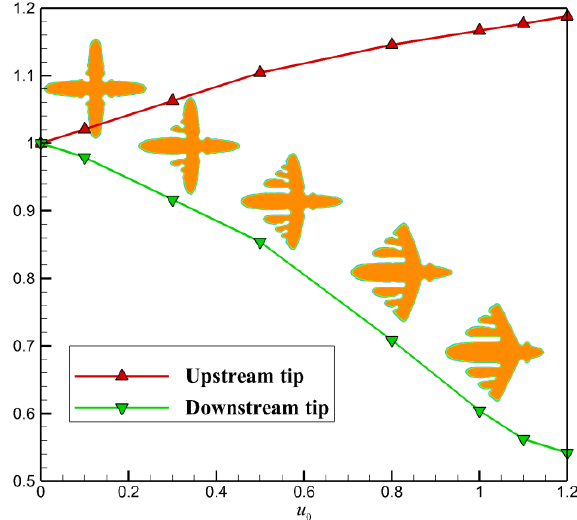
Figure 2. Quantitative study of the flow effect on the growth of the two main branches in the horizontal direction. The ratio between the averaged tip velocities with and without fluid flow is chosen as the measure. The two lines are the relative growth rates of the two branches at different inlet flow velocity.